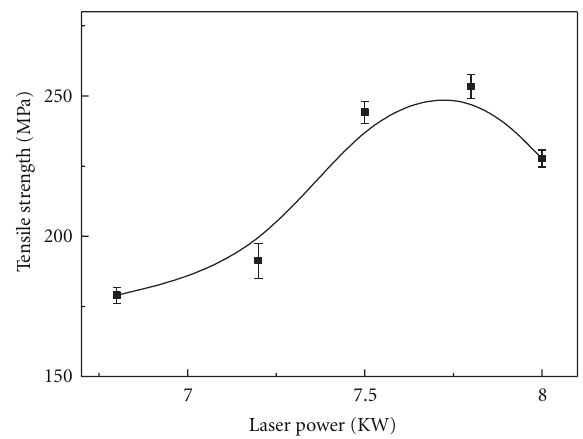
Figure 8: Relationship between tensile strength and laser power at the welding speed of 4m/min.